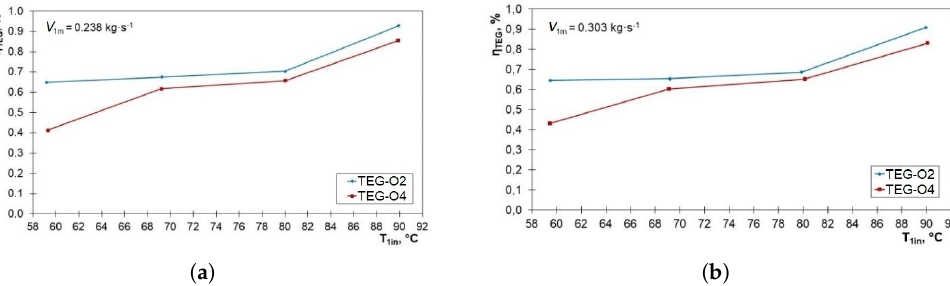
Figure 18. Efficiency characteristics of η TEG at different T 1 in temperatures and selected flow